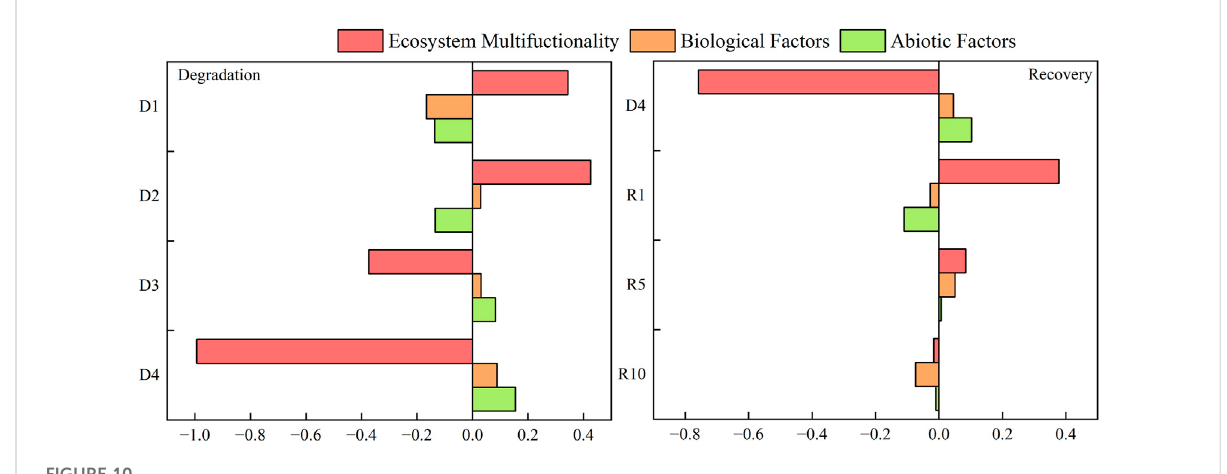
FIGURE 10 Changes in plant ‒ soil feedback index at different degradation stages and recovery